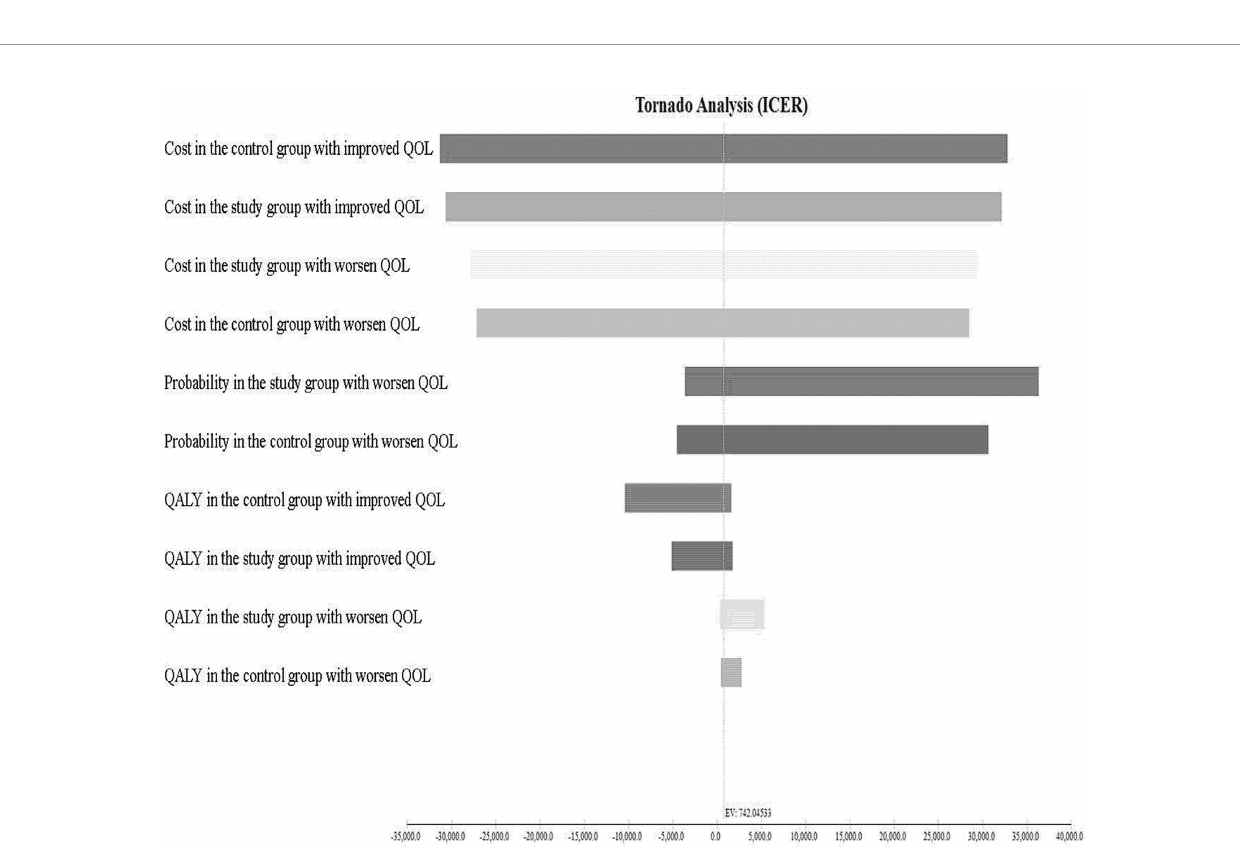
FIGURE 6 | Tornado diagram showing one-way sensitivity analysis results. Costs are expressed in US$ 2020. ICUR, incremental cost-utility ratio; QOL, quality of life.